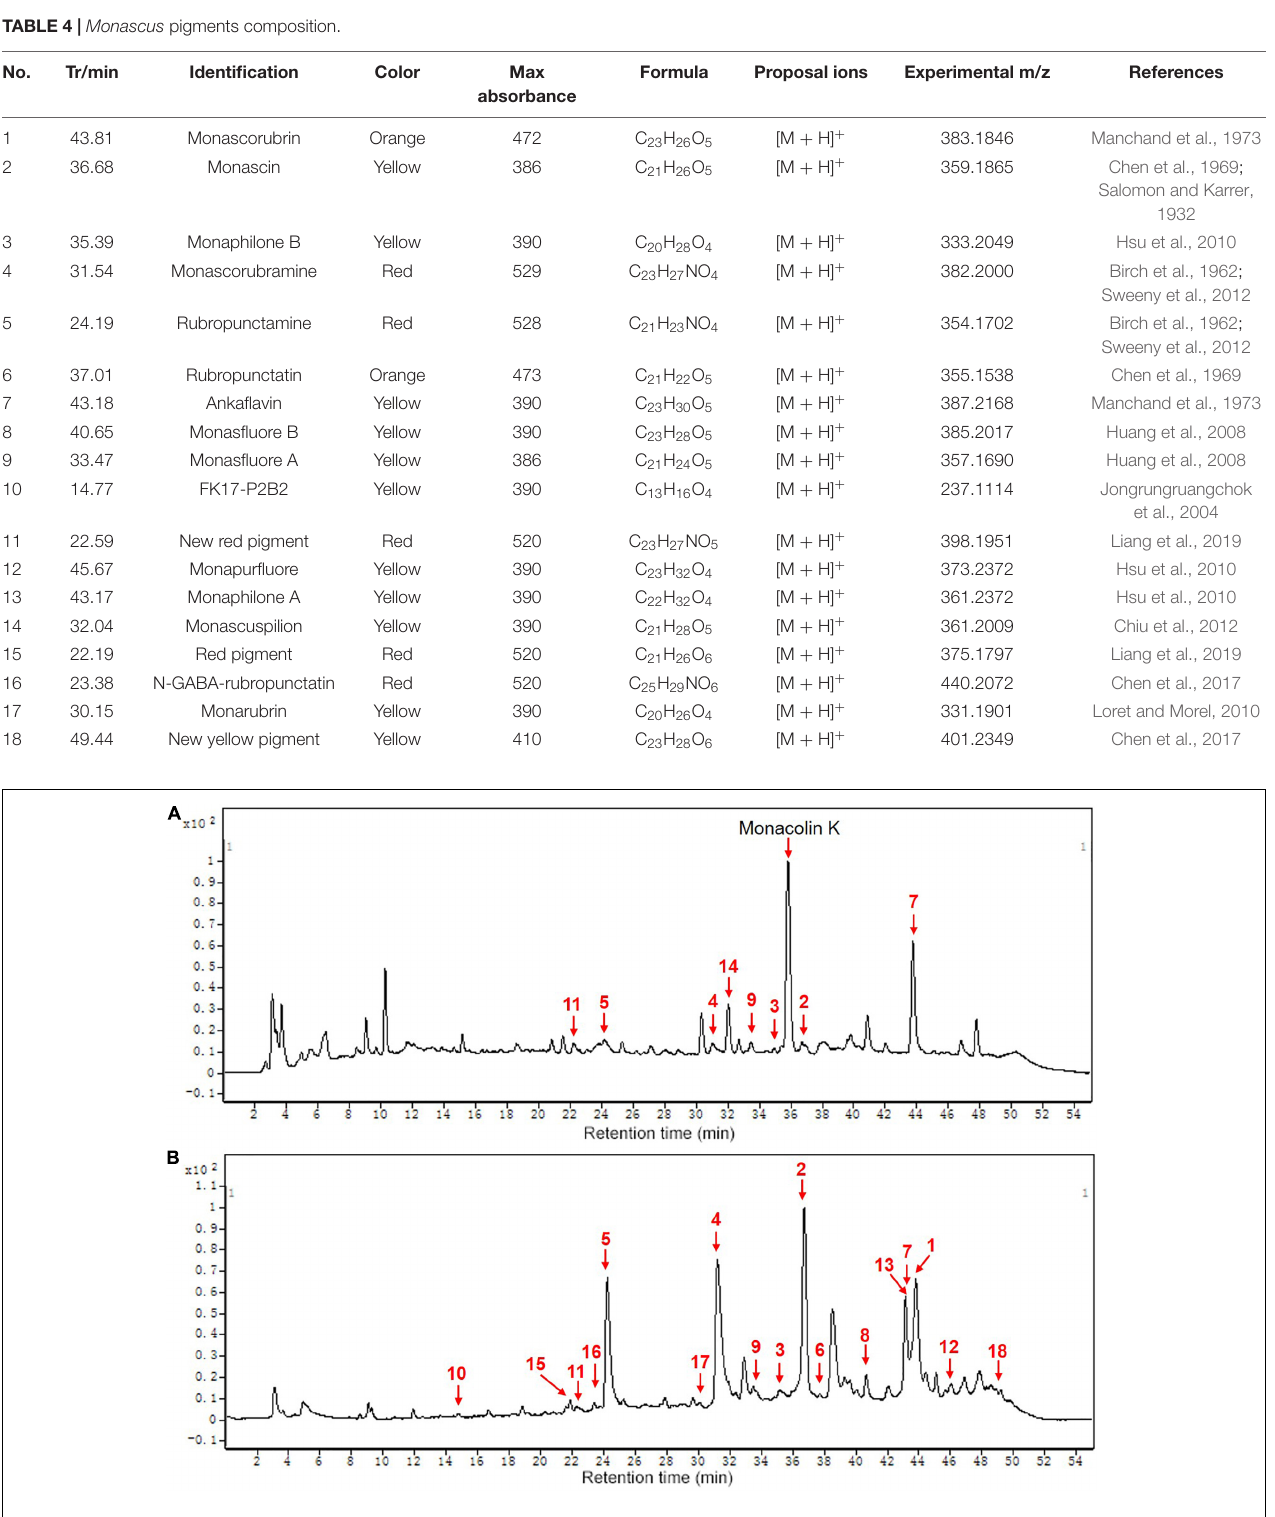
FIGURE 5 | The chemical composition of MPs of functional Qu (FQ) and coloring Qu (CQ), respectively. (A) functional Qu (FQ). (B) Coloring Qu (CQ). 1, monascorubrin; 2, monascin; 3, monaphilone B; 4, monascorubramine; 5, rubropunctamine; 6, rubropunctatin; 7, ankaflavin; 8, monasfluore B; 9, monasfluore A; 10, FK17-P2B2; 11, new red pigment; 12, monapurfluore; 13, monaphilone A; 14, monascuspilion; 15, red pigment; 16, N-GABA-rubropunctatin; 17, monarubrin; 18, new yellow pigment.